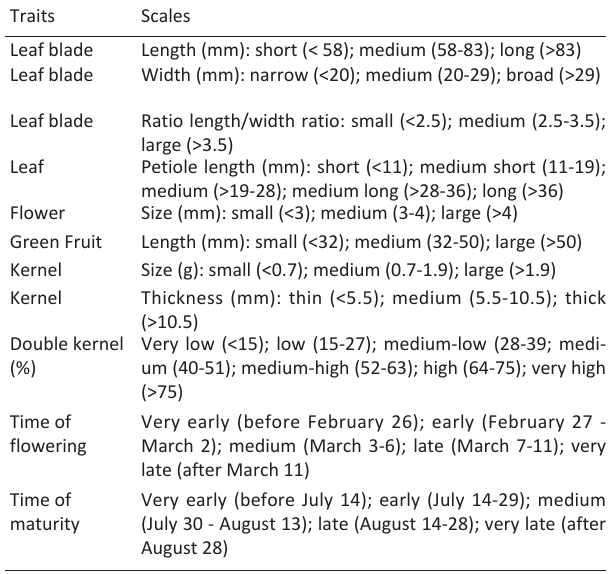
Table 3 - Scales defined for quantitative and phenological traits observed on the almond accessions from Afghanistan